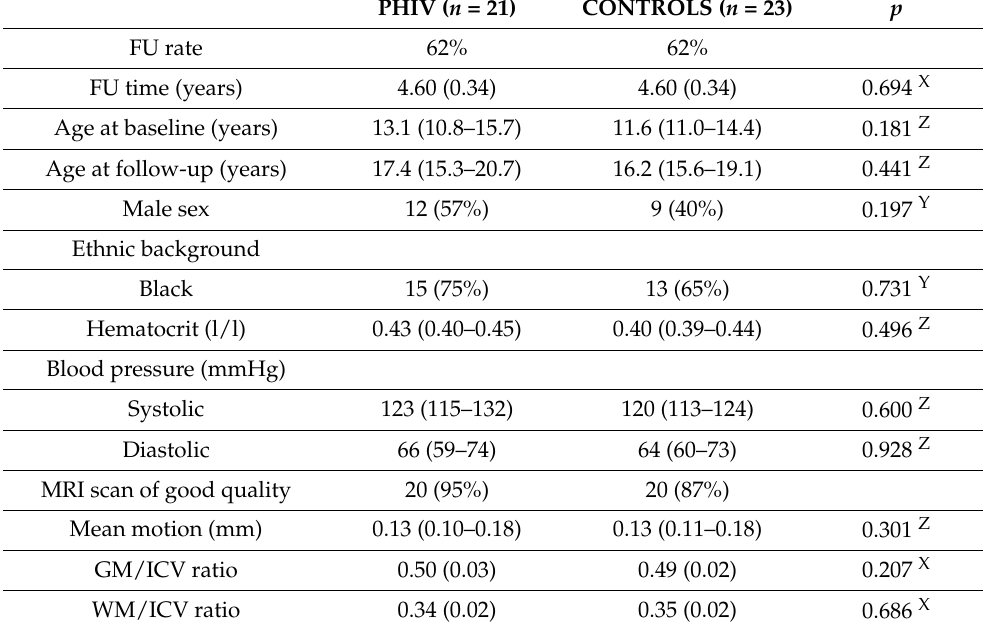
Table 1. Participants’